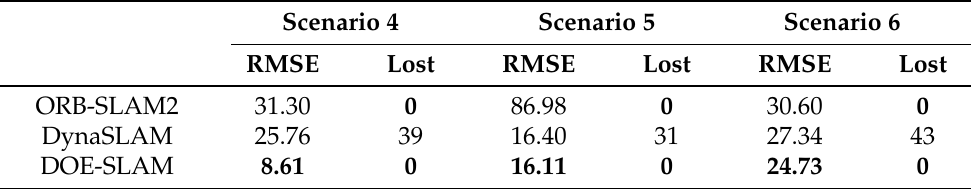
Table 3. Comparison of the RMSE of ATE (cm) and number of lost frames for fully dynamic object